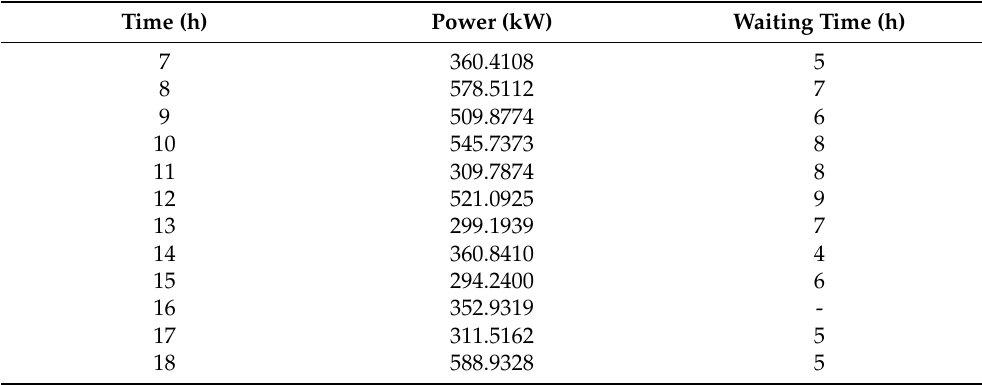
Table 3. Load shifting considering peak load